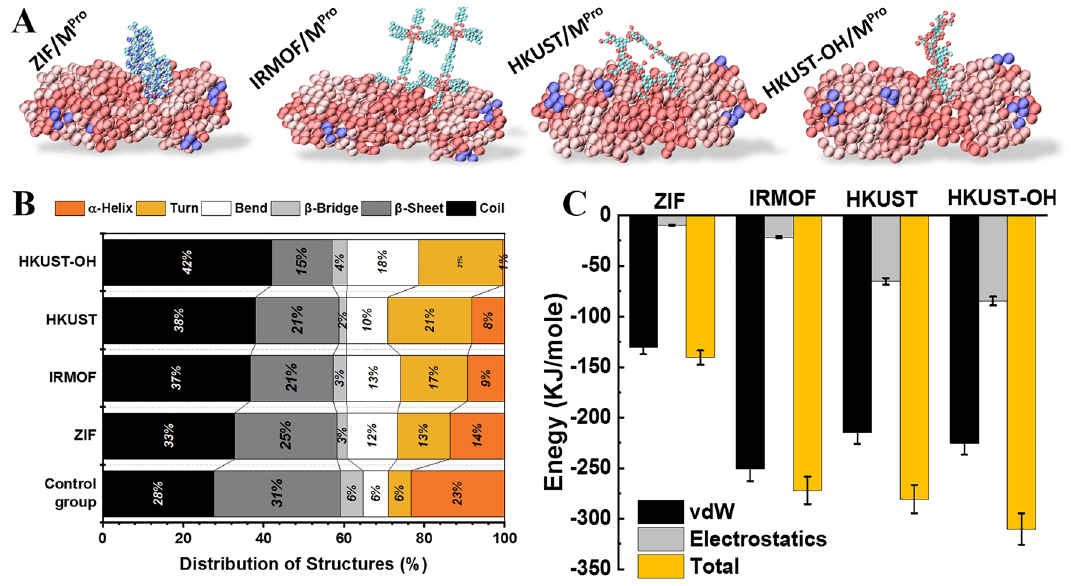
Figure 5. Evaluation of the MOFs’ impact on M pro structure: ( A ) Snapshots of the simulation of COVID-19 M pro with MOF nanostructures, ( B ) distribution of secondary structure of MOFs and control group, ( C ) energy of